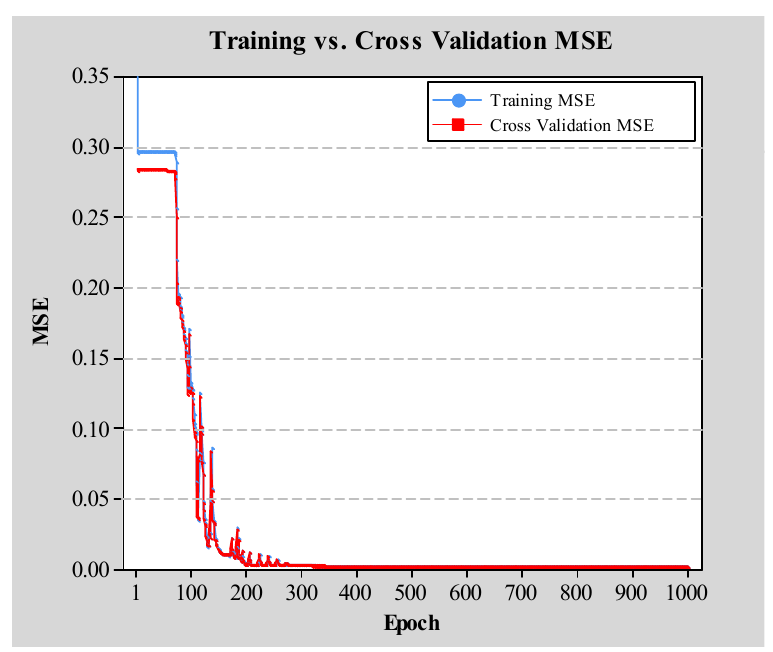
Figure 4. MSE vs.